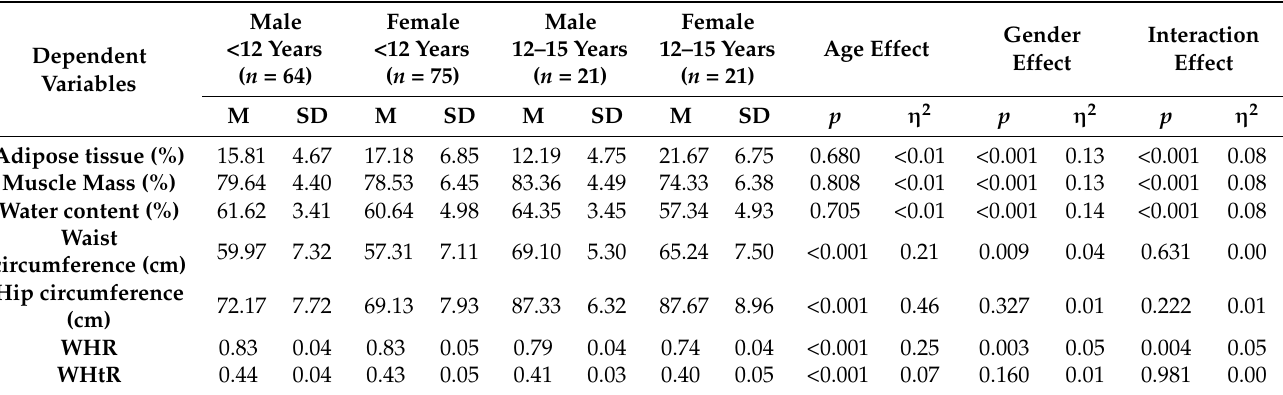
Table 5. Analysis of the interaction effect of pubertal age and gender on body composition compo-